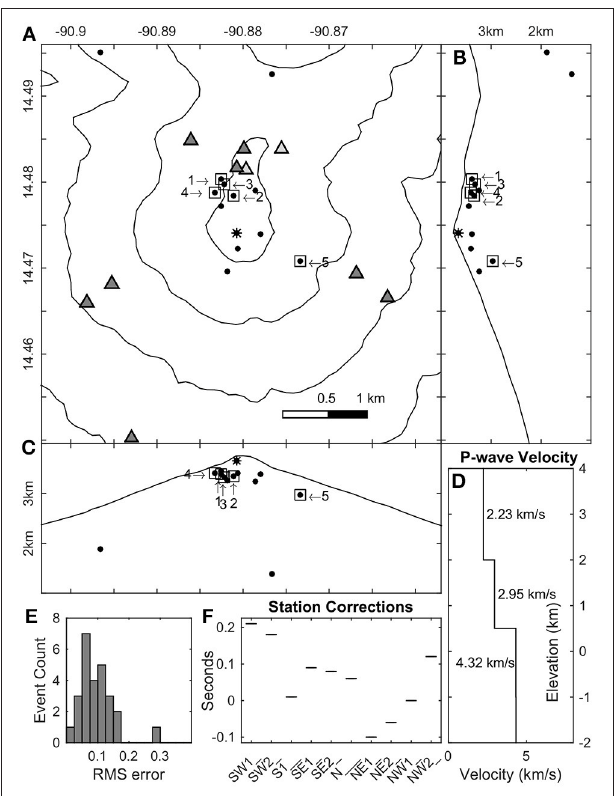
FIGURE 4 | (A) Map of final locations of 5 PWSCEs (boxes and numbers), 7 other events (dots) and 14 shots (asterisk), all based on 1-D P-wave velocity model. Dark triangles represent stations with positive corrections, light triangles represent stations with negative corrections. (B) North-South cross section through Fuego vent, sharing latitude coordinates with (A) . (C) East-West cross section through Fuego vent, sharing longitude coordinates with (A) . (D) 1-D velocity model (E) Histogram of RMS errors for the events (F) Corrections applied to each station in final 1D model.